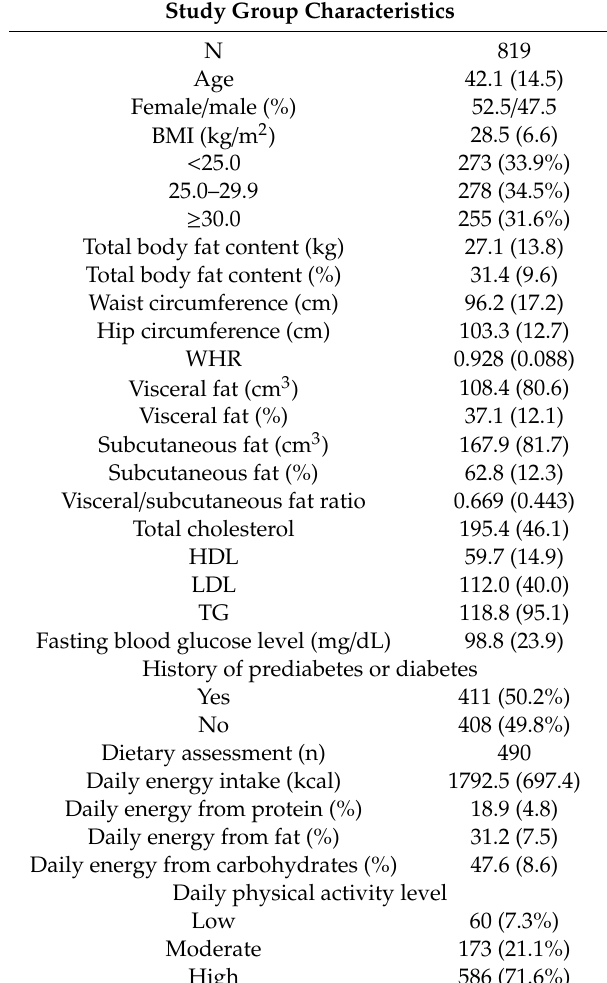
Table 1. Study group